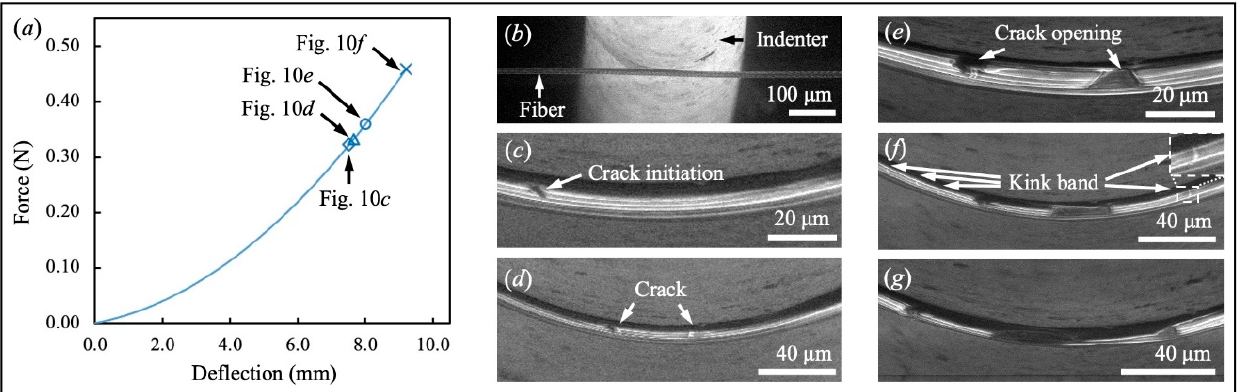
Figure 10. Failure behavior of a representative Dyneema ® SK76 fiber. ( a ) Force-deflection curve; Real-time fiber morphology at S tr = ( b ) 0; ( c ) 7.521 mm; ( d ) 7.651 mm; ( e ) 8.005 mm; ( f , g ) 9.205 mm.